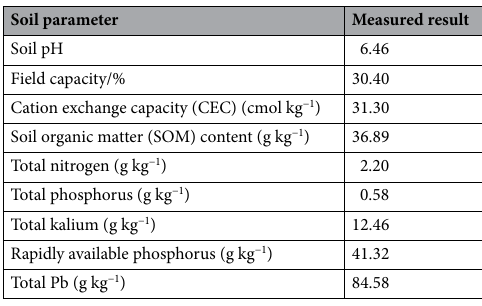
Table 1. Physicochemical properties of soil.